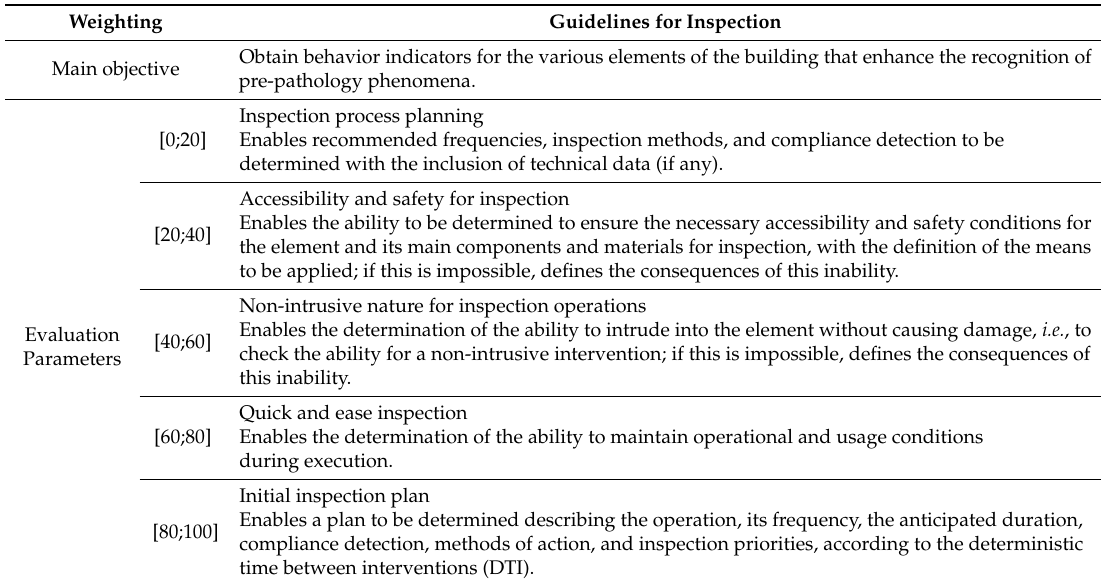
Table 3. Guidelines to define the Eid weighting for